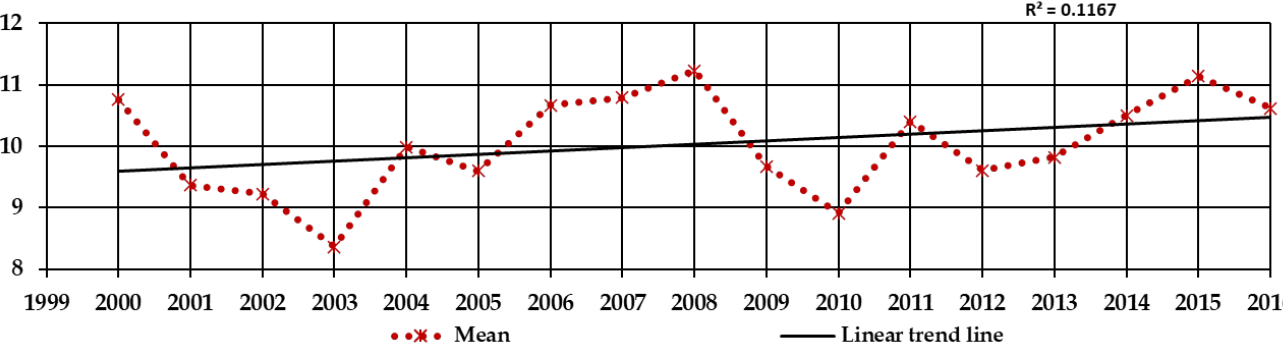
Figure 2. The total yearly mean air temperatures ( ◦ C) in the years 2000–2016, measured in the PAS Botanical Garden CBDC in Powsin, and the linear trend line of increase the temperature in this period.